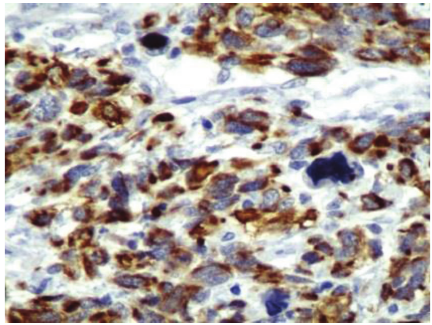
Figure 10: MSA: cytoplasmic staining: × 200.